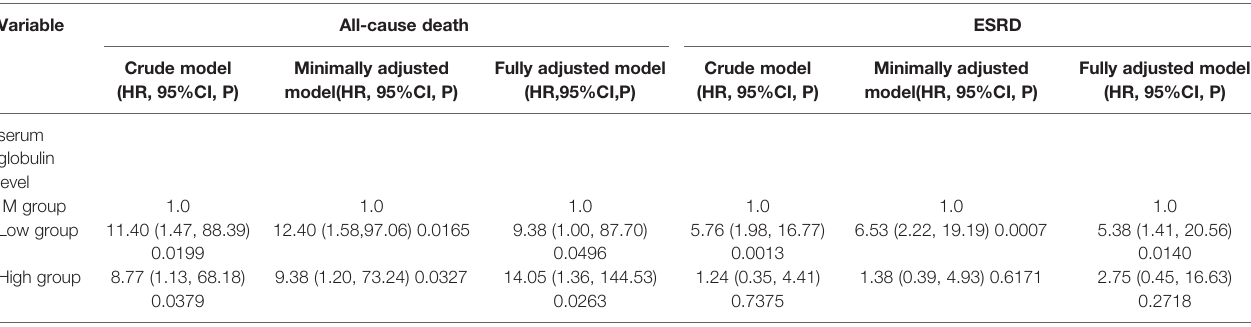
TABLE 4 | Relationship between serum globulin level and All-cause death and ESRD in different models.